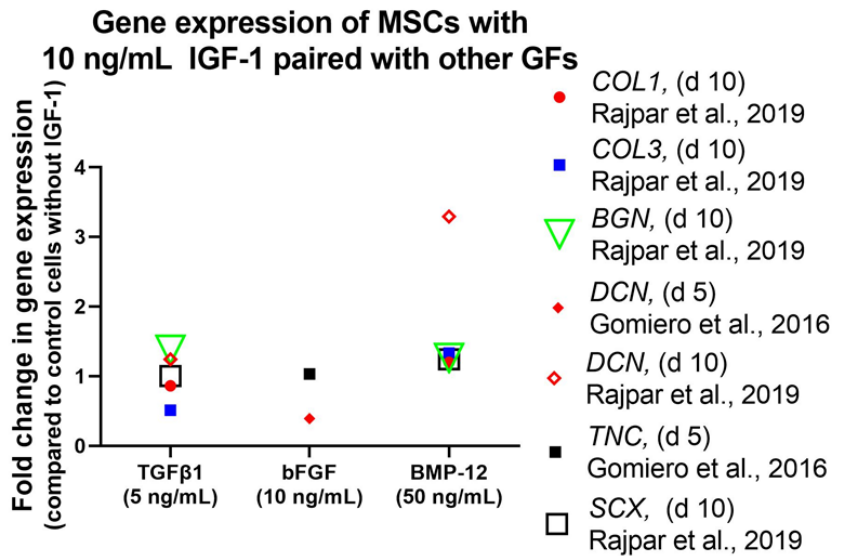
Figure 8. Impact of varying growth factor concentrations on the gene expression of human MSCs in the presence of 10 ng/mL IGF-1 and other growth factors as indicated. Further information: Equine MSCs in high-glucose DMEM containing 10% FBS and AA (37.5 µg/mL) [88] and equine tenocytes in DMEM containing 20% FCS [87].